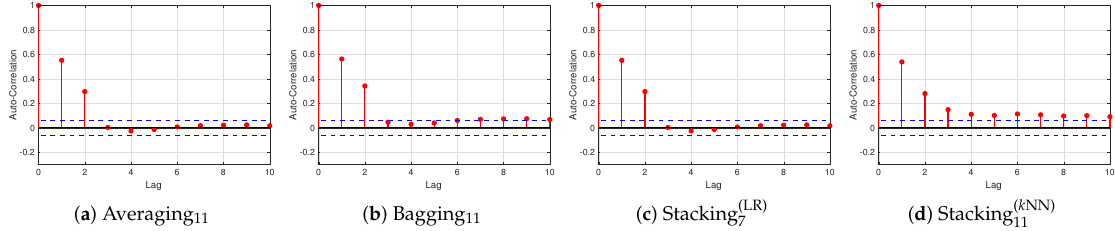
Figure 8. Autocorrelation of residuals for ETH dataset of ensemble models using CNN-BiLSTM as base learner.